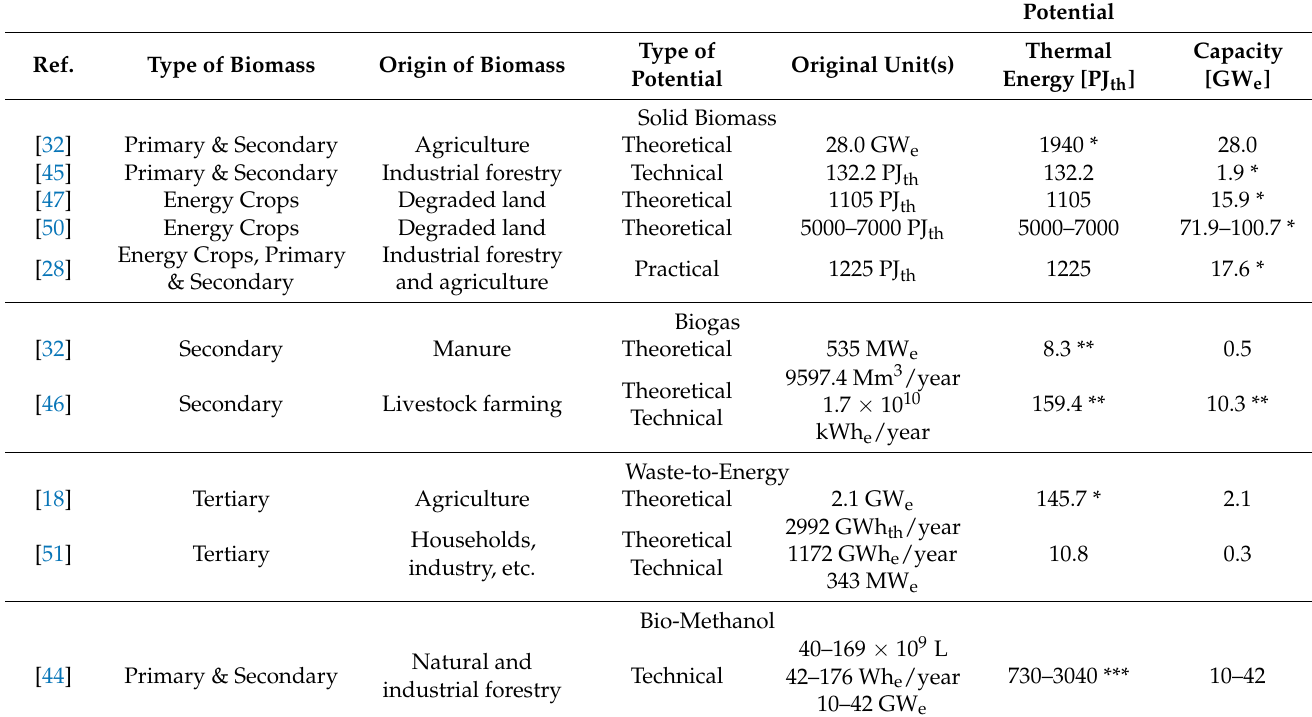
Table 3. Biomass potentials in Indonesia. * (Co-)firing in steam plants with efficiency and capacity factor of 34.0% and 74.8% respectively. ** Combustion in gas plants with efficiency and capacity factor of 38.4% and 18.8%, respectively [2,4]. *** Density and heat value of methanol 792 kg/m 3 and 22.7 MJ/kg, respectively.